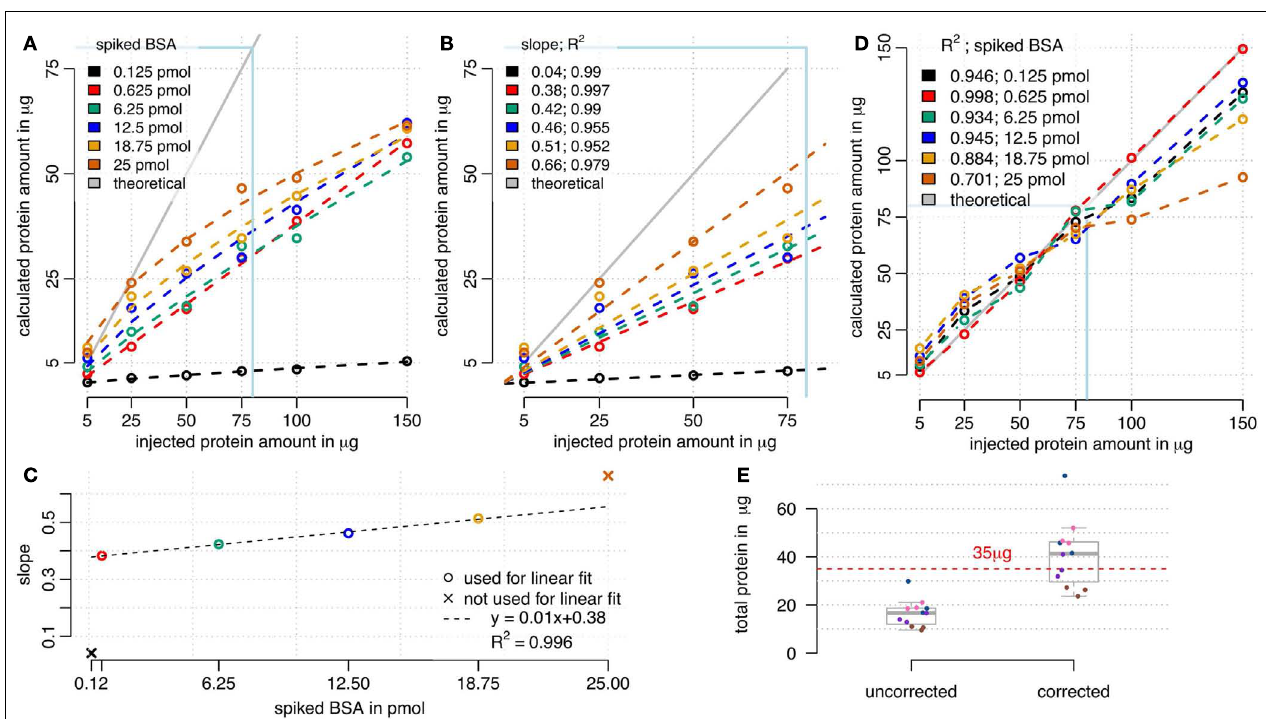
absolute protein amounts by multiplying with reciprocal slope values from (B) . Multiplication of cumulated absolute protein loads with corresponding reciprocal slopes (D) improved approximation to ideal curve especially for lower BSA loads (C) . (E) Cumulated absolute protein amounts of the starvation experiments were underestimated using 3.8pmol of BSA and 35 µ g of protein, but approximated the injected protein amount after correction.Technical replicates are indicated by equal colors.The correction factor was calculated using the linear model from (D)